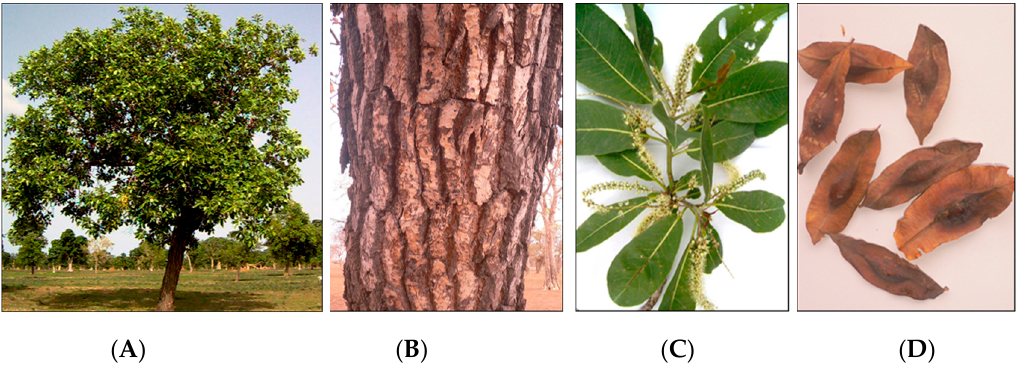
Figure 1 . Terminalia brownii . ( A ) tree in savannah woodland; ( B ) stem bark; ( C ) flowers and leaves; ( D ) fruits. Photo: E. Y. A. Salih and Dr. H. H. Gibreel, 2006.